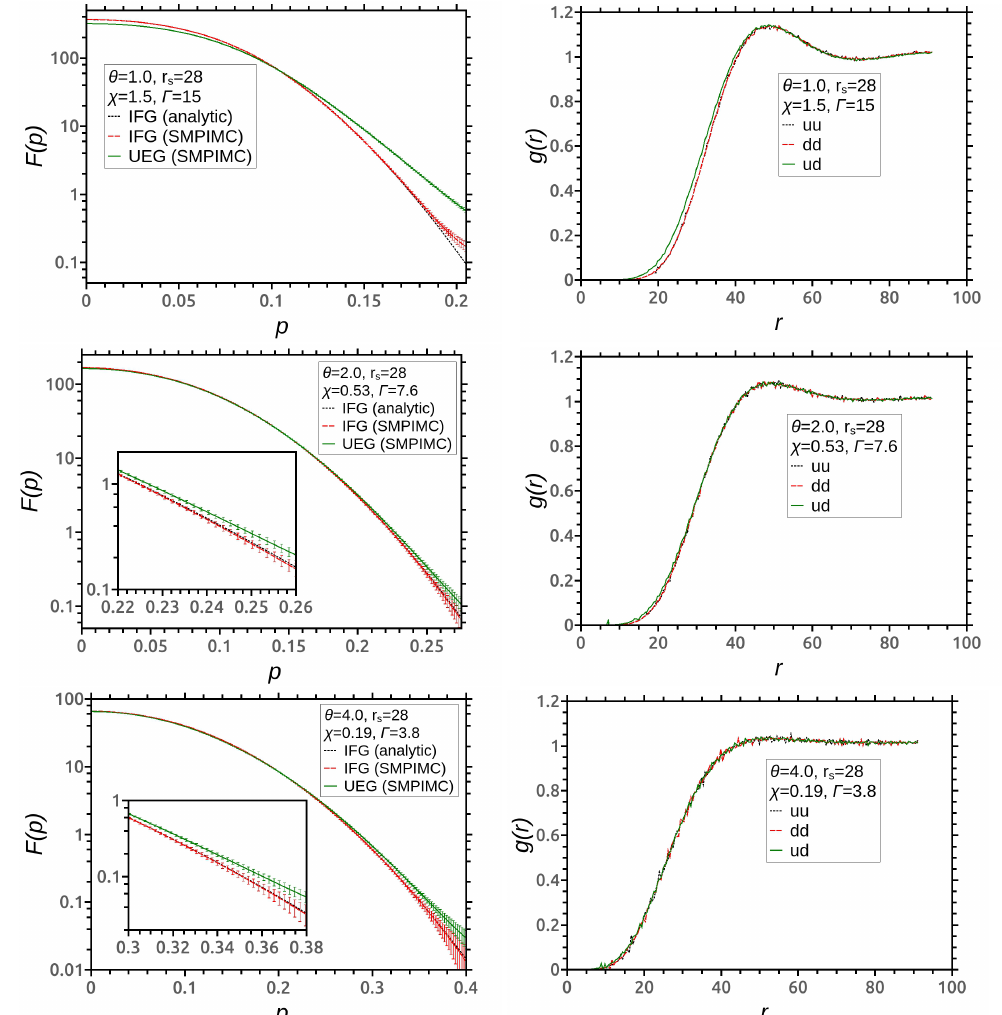
Figure 4. Left plots: single-particle MDFs of the unpolarized UEG at r s = 28 and θ = 0.5,1,4 calculated with the SMPIMC method. The results are compared with the SMPIMC for the IFG at the same conditions and with the analytical Fermi distributions. Right plots: PCFs g uu , g dd , and g ud of the